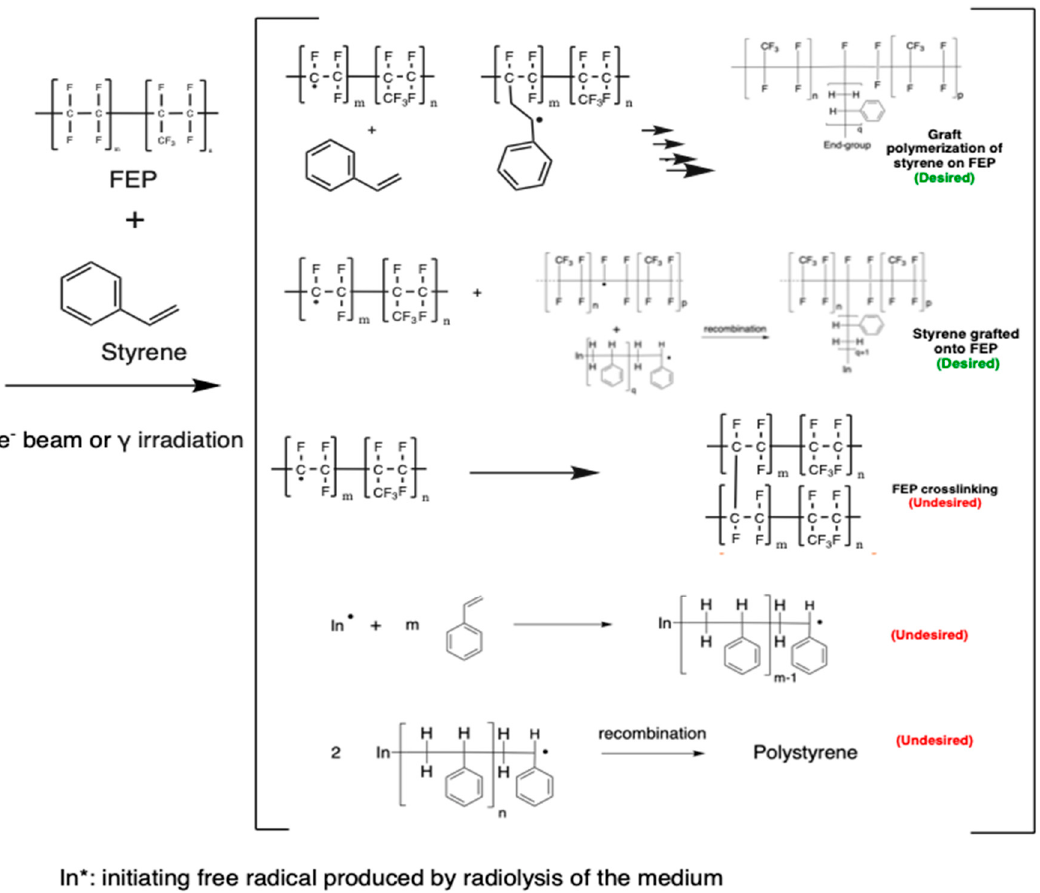
Figure 8. Possible chemical reactions between fluorinated ethylene propylene (FEP) and styrene during direct and indirect irradiation. The radicals produced will undergo propagation resulting in the polymerization of styrene. Undesired homopolymerization and FEP crosslinking may also take place [165].